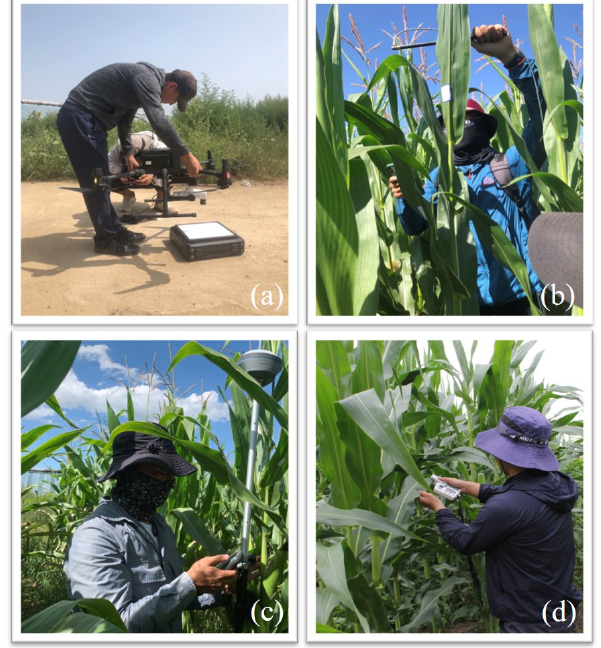
Figure 2. ( a ) Cubert S185 hyperspectral white board calibration; ( b ) ASD high spectrometer; ( c ) RTK mobile station to determine SPAD observation position; ( d ) SPAD measurement.